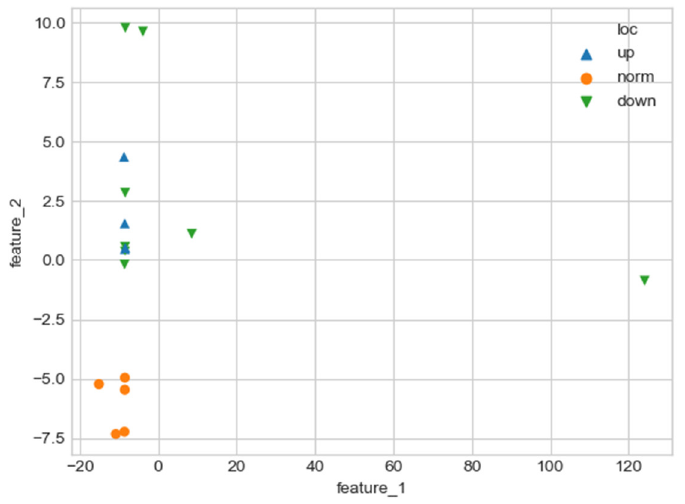
Figure 23. Comparison of quantitative characteristics of geometry for aortas. Blue triangles indicate aortas with pathology in the proximal sections, green triangles—aortas with pathology in the distal sections, and orange circles—aortas without severe pathology.